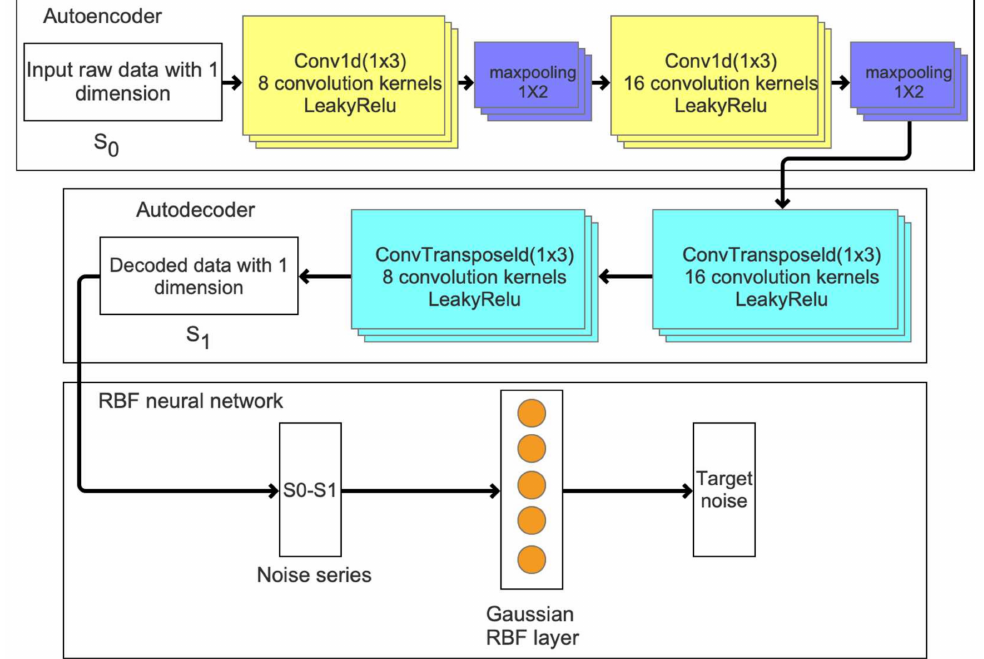
Figure 4. Framework of the noise optimization algorithm based on autoencoder and RBF neural